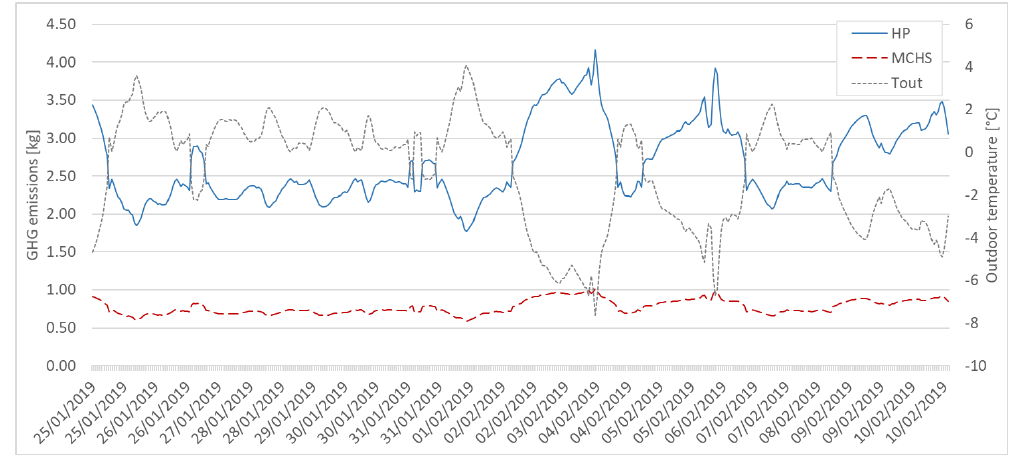
Figure 7. Hourly GHG emissions to cover the heating demand in Estonia for both NEHS and HP.